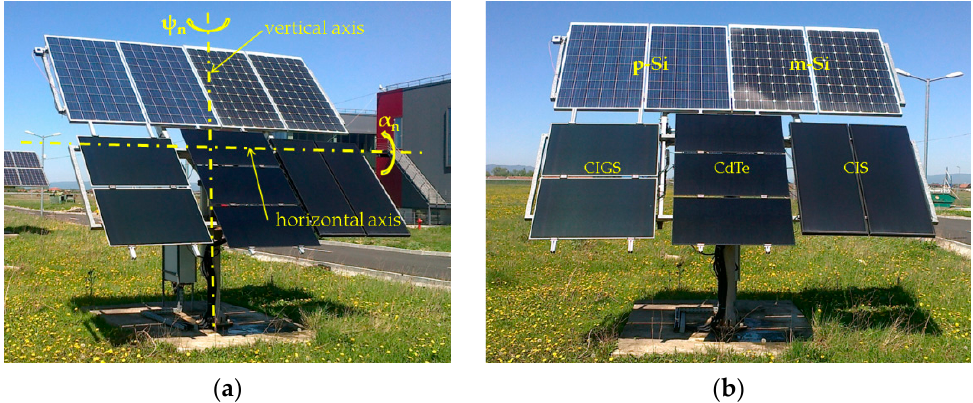
Figure 3. Azimuthal solar-tracking system for a PV platform with five PV modules ( a ) and fixed PV platform ( b ) installed in the RESREC of the Transilvania University of Brasov, Romania.